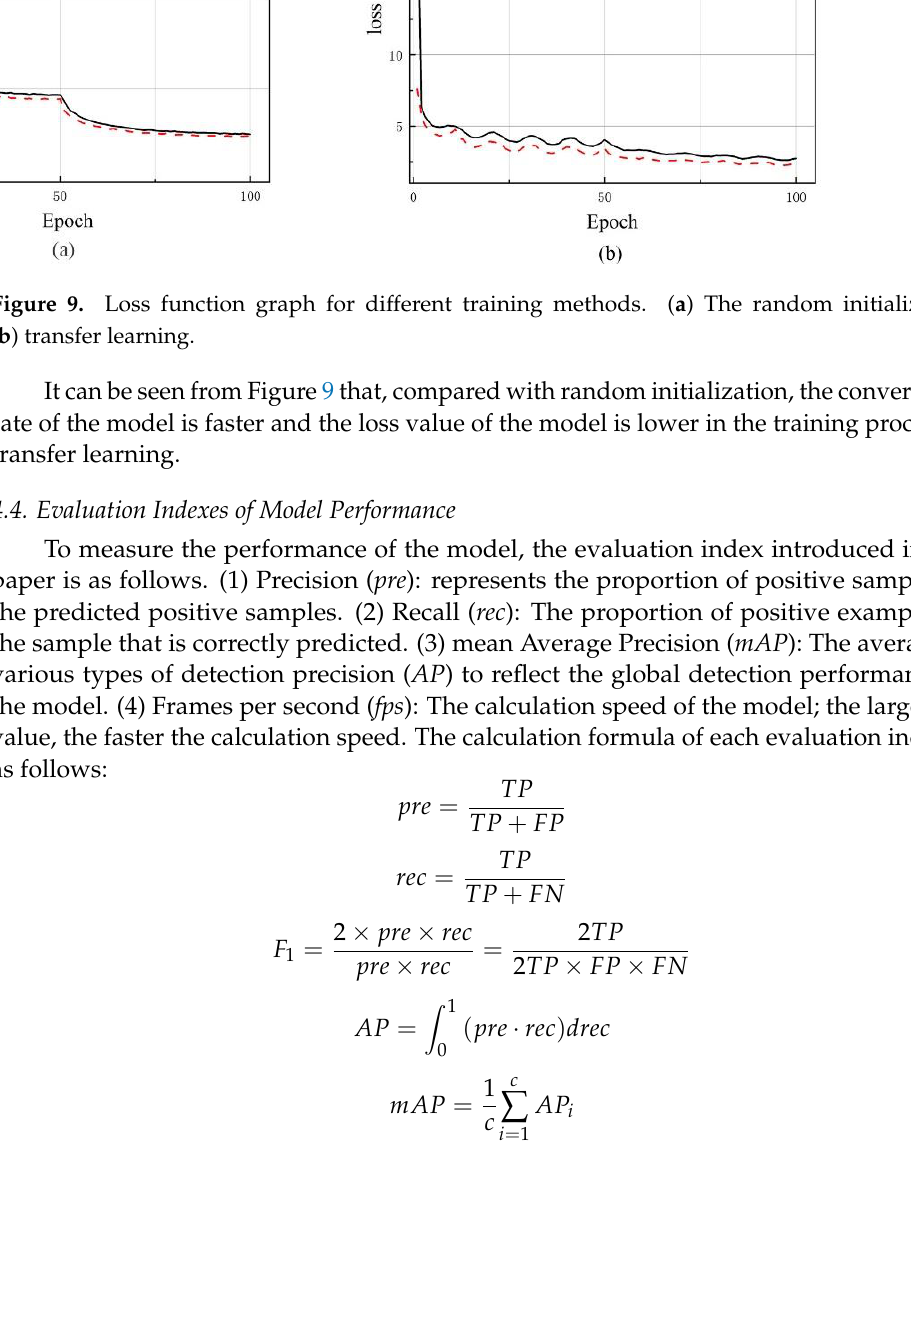
Figure 8. Number of targets after Instance-Balance Augmentation.